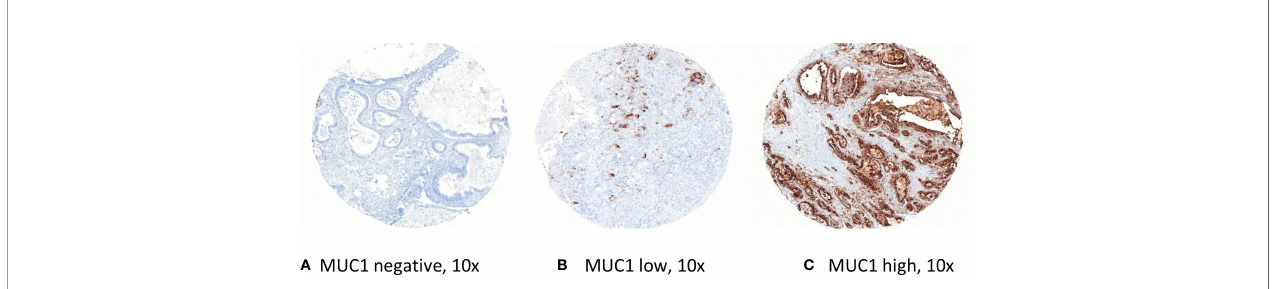
FIGURE 1 | Representative TMAs (A) MUC1 negative, (B) MUC1 low, and (C) MUC1 high.